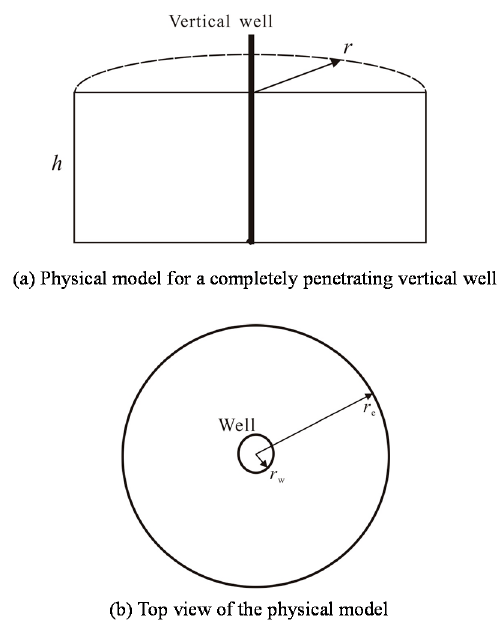
Figure 1. Schematic of the physical model for a vertical well in a finite closed reservoir.